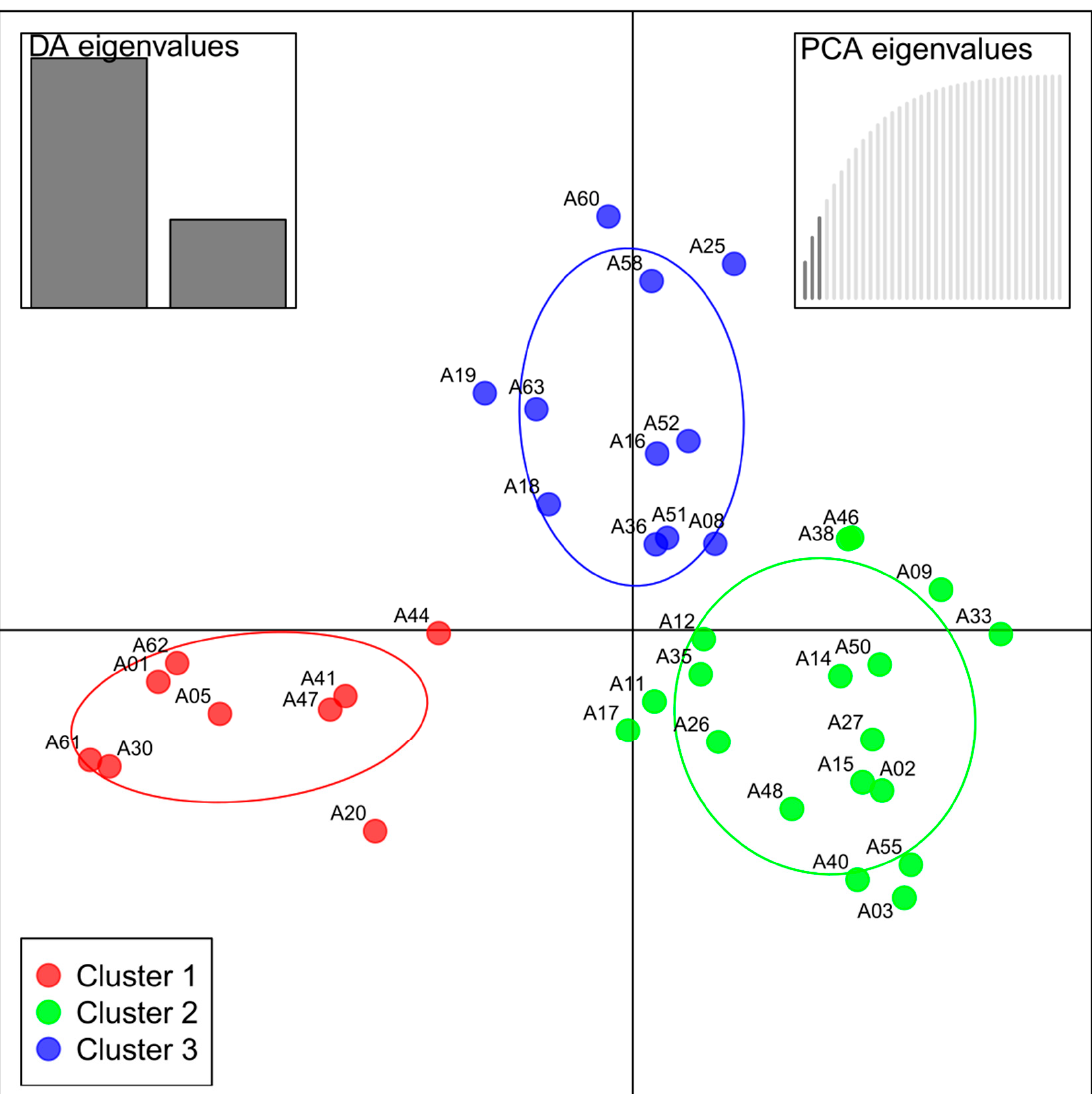
Figure 2. Scatter plot of discriminant analysis of principal components (DAPC) for SSR-data, three PCs and three DAs retained. Color code and group-ellipses according to the three calculated clusters. The box on the upper left shows the retained DA eigenvalues, while the box on the upper right shows that three PCA eigenvalues have been retained.